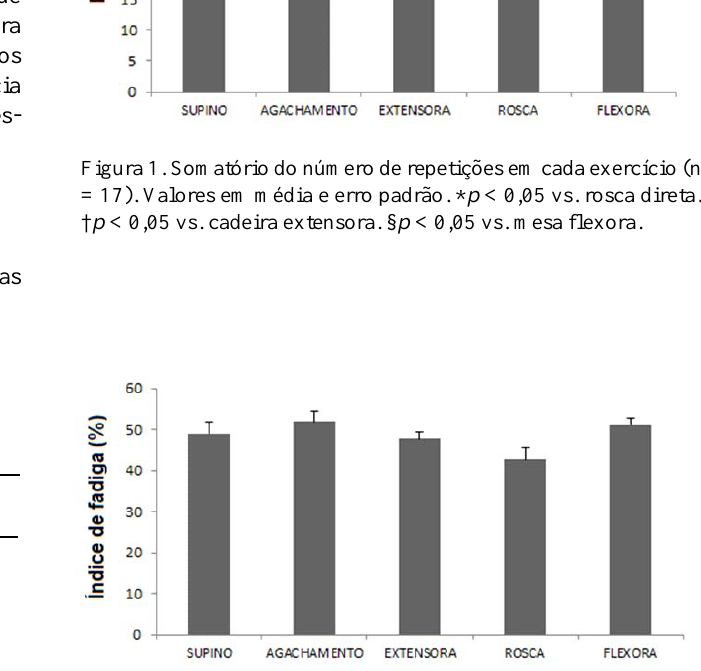
Figura 2. Índice de fadiga nos cinco exercícios, calculado a partir das alterações observadas entre as séries 1 e 3 (n = 17). Valores em média e erro